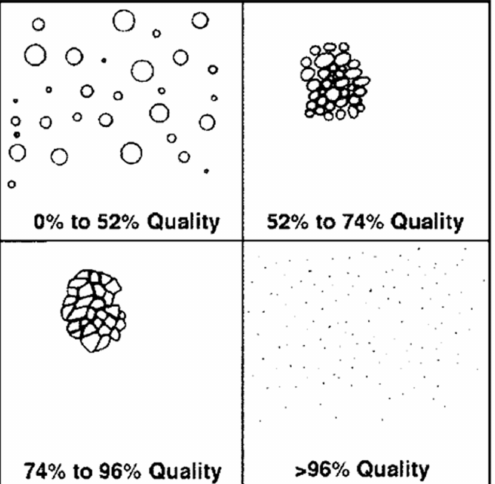
Figure 1. Foam structure at different quality (Reprinted with permission from Hutchins & Miller, [29]). Copyright 2005, Society of Petroleum